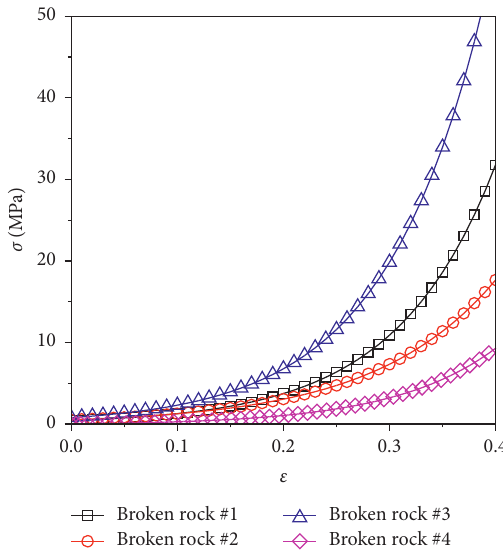
Figure 2: Stress-strain curves of various broken rocks